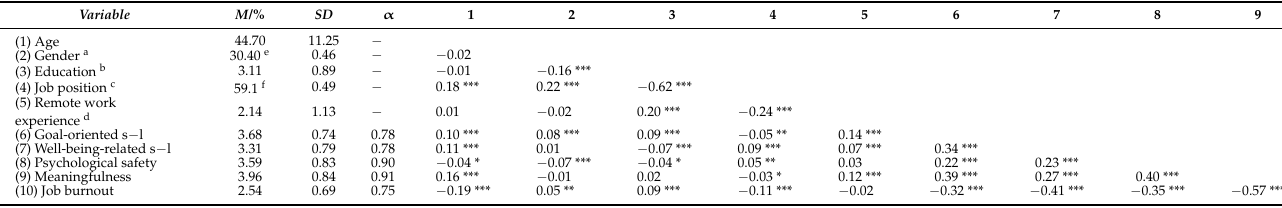
Table 1. Descriptive Information on the Study Variables ( N =